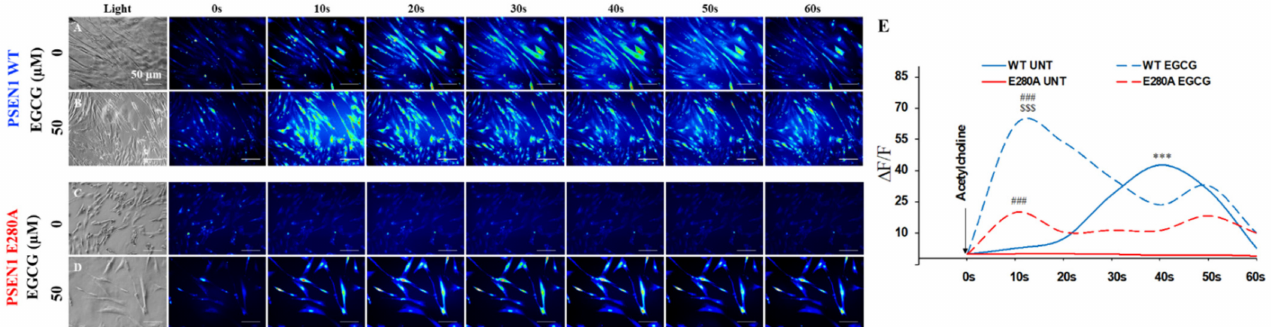
Figure 5. EGCG does not reduce the levels of extracellular A β 42 peptides in PSEN1 E280A ChLNs. After 7 days of transdifferentiation, WT PSEN1 and PSEN1 E280A ChLNs were left untreated or treated with EGCG in RCm for 4 days. ( A ) ELISA quantification of extracellular A β 42 peptides in supernatants. ( B ) Western blot showing the A β 42 migration profile alone or after incubation with EGCG or 6E10 antibody. Data are presented as means ± SD. # p < 0.05, # represents differences compared to UNT PSEN1 WT cells. The histograms represent 1 out of 4 independent experiments, and blot represents 1 out of 2 independent experiments.